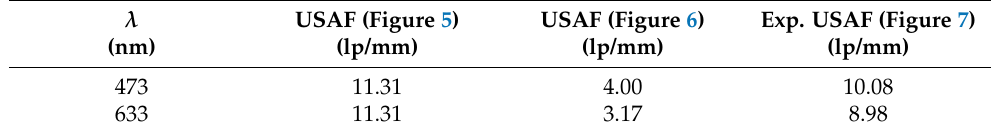
Table 3. HLs resolution using the USAF test.